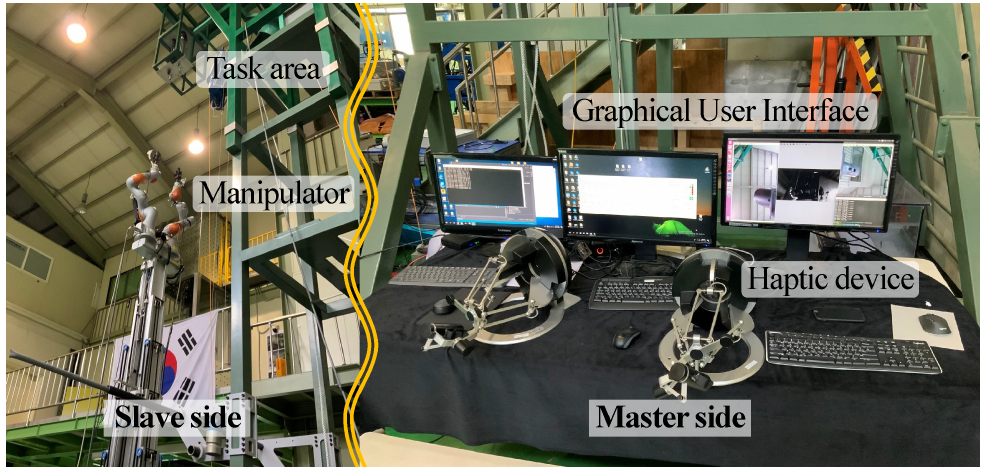
Figure 5. Dual-arm master–slave teleoperation experimental environment. The teleoperator operates two master devices (left-handed and right-handed) to manipulate dual-arm slave robots. The dual- arm manipulator can be raised to a height of 9 m using the telescopic mast below the robotic